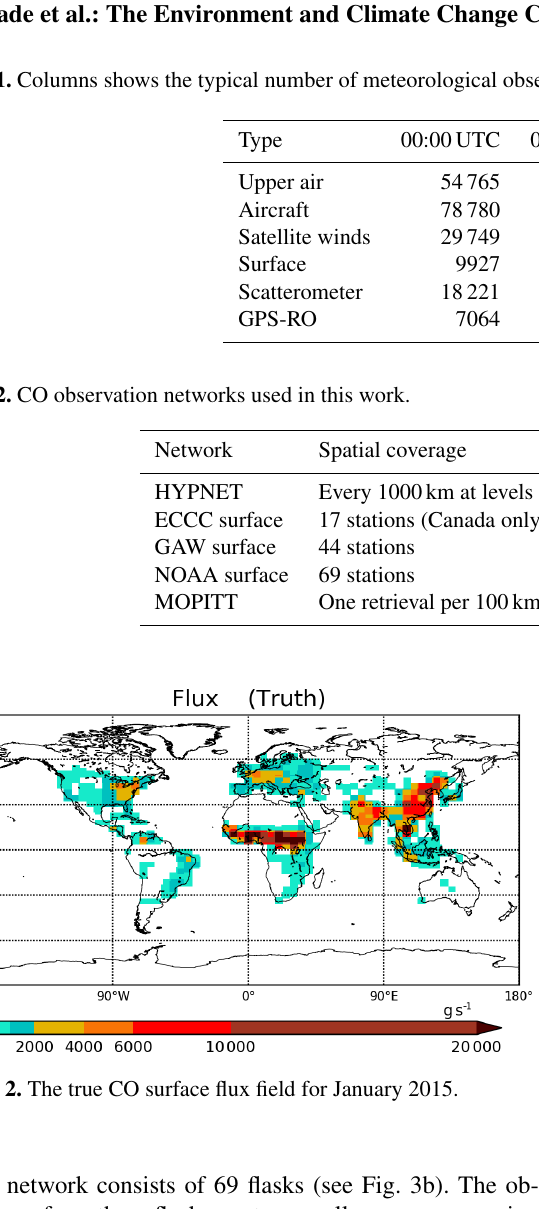
vation network consists of 69 flasks (see Fig. 3b). The ob- servations from these flasks are temporally sparse, averaging approximately one per